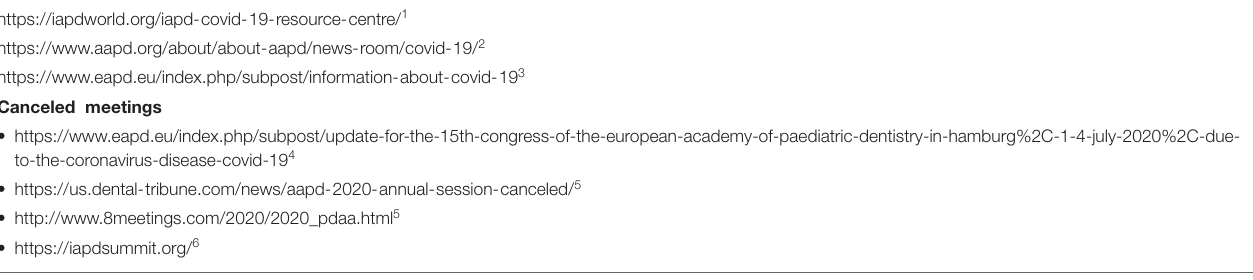
TABLE 1 | Online resources for students to learn pediatric dentistry during COVID-19 from various pediatric dental associations and canceled meetings.